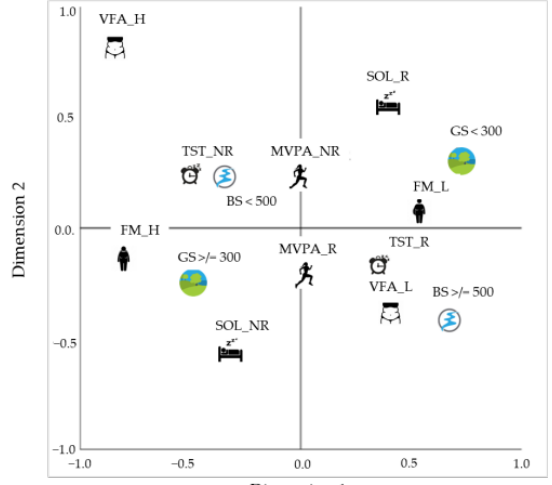
Figure 4. Centroid plot.